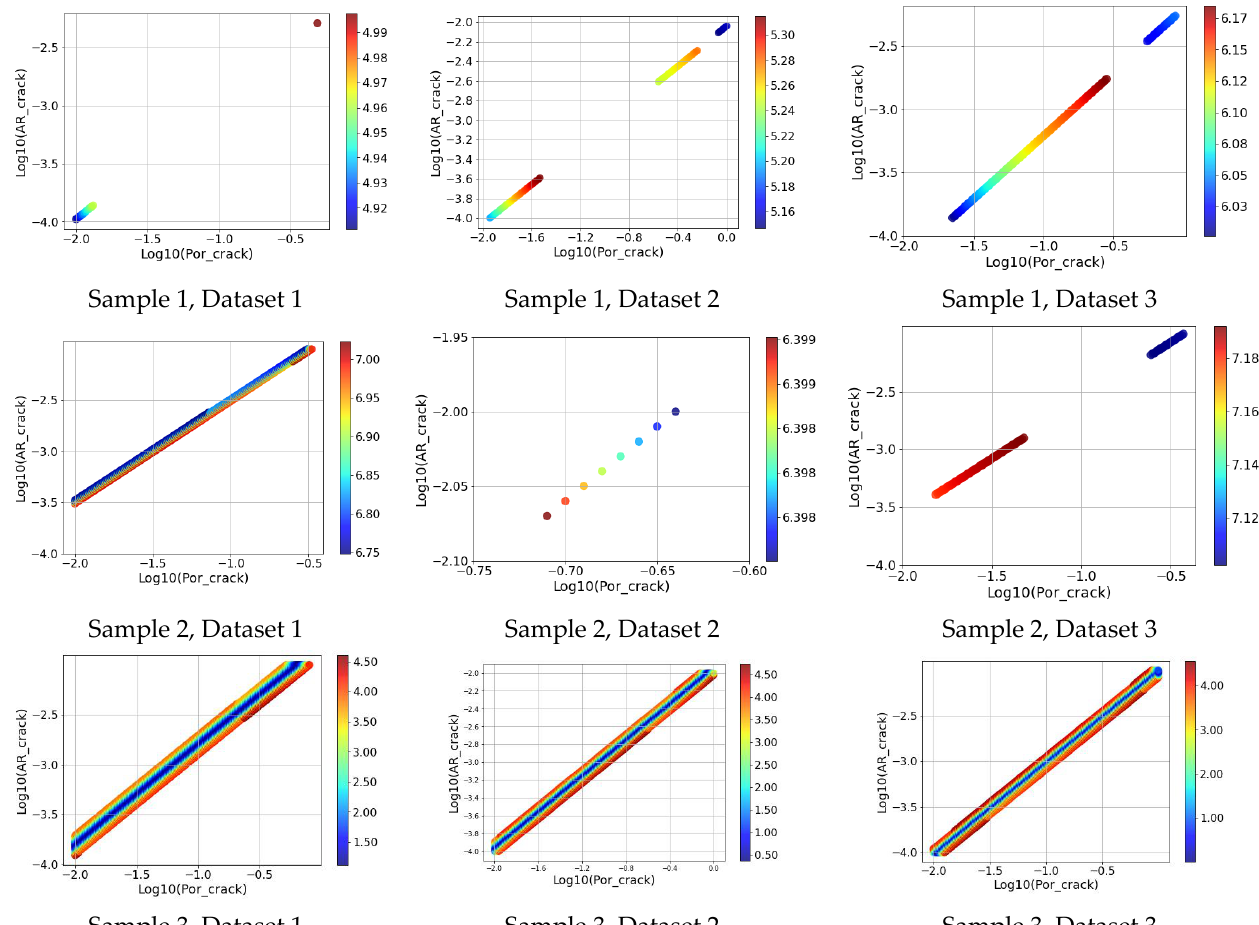
Figure 11. Surfaces of characteristic Discrepancy measure (%) versus microcrack porosity and their aspect ratio for Sample 1 ( left ), Sample 2 ( middle ), and Sample 3 ( right ). The solutions for Dataset 1 are shown (for experimental porosity and aspect ratio obtained for small sample).